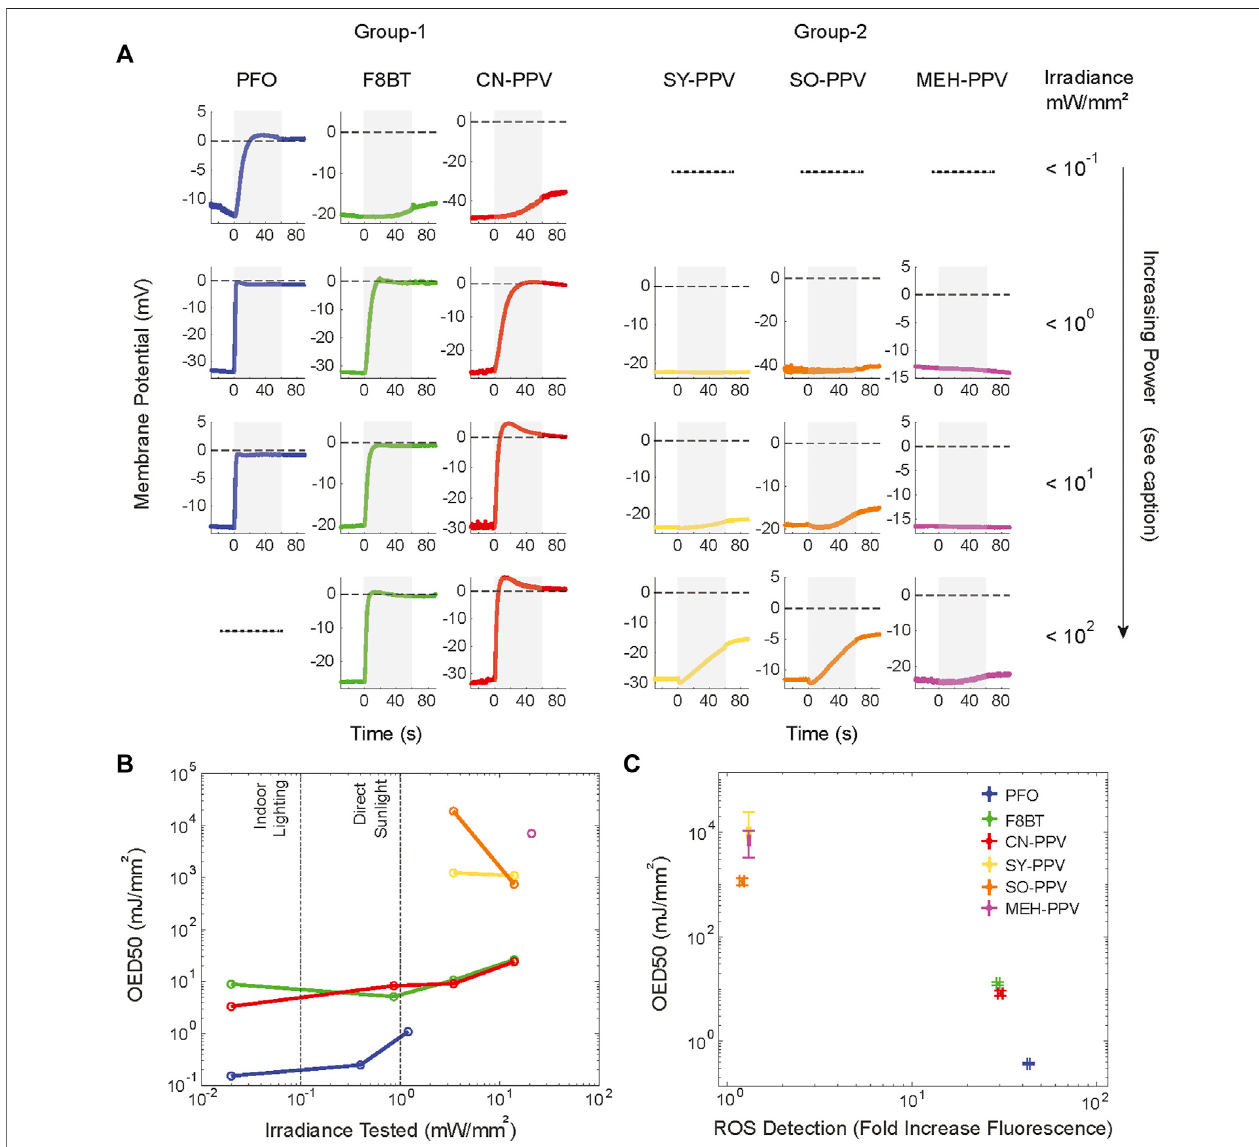
FIGURE 5 | Kinetics and waveform of the effects of photostimulation of cells grown on group 1 materials and progressive changes of the photo-response of cells grown on group 2 materials. Membrane potentials of HEK293 cells were recorded during 1-min photoexcitation at multiple irradiance levels. (A) Mean traces of the membrane potential response during 1-min illumination at increasing irradiances (N = 4 – 10 cells per material), light onset at t = 0. Tested irradiances per material (mW/ mm 2 ); PFO (0.02,0.4,1.2; 390 nm), F8BT (0.02,0.86,3.44,14; 473 nm), CN-PPV (0.02,0.86,3.44,14; 473 nm), SY-PPV (0.86,3.44,14; 473 nm), SO-PPV (0.86,3.44,14; 473 nm), and MEH-PPV (0.86, 5.7, and 21; 548 nm). (B) Scatter plot of mean OED 50 as a function of irradiance and material used. (C) Observation of an inverse power law relationship between measured ROS evolution (fold increase in reporter fl uorescent intensity) and mean OED50 value obtained across irradiance powers per material (OED50 [mJ/mm 2 ] mean ± SEM; PFO (0.37 ± 0.02), F8BT (12.69 ± 0.81), CN-PPV (8.35 ± 0.93), SY-PPV (9.6x10 3 ± 1.52x10 3 ), SO-PPV (1.15x10 3 ± 0.18x10 3 ), and MEH-PPV (6.98x10 3 ± 3.76x10 3 ).